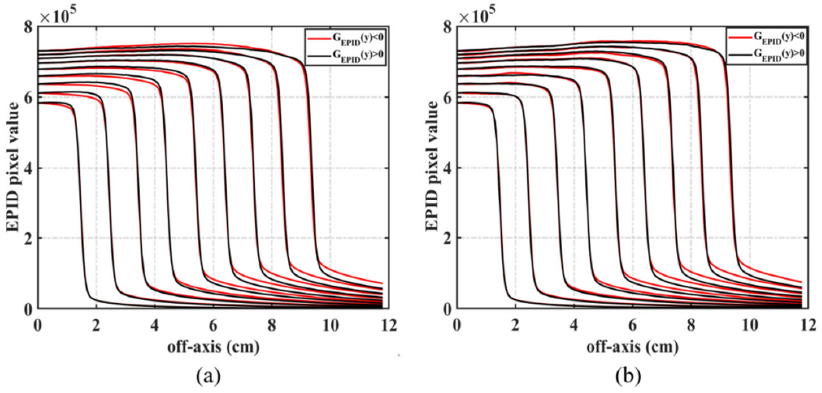
Figure 4. Values of the uncorrected ( a ) and corrected ( b ) EPID images in the inline direction for different fields.